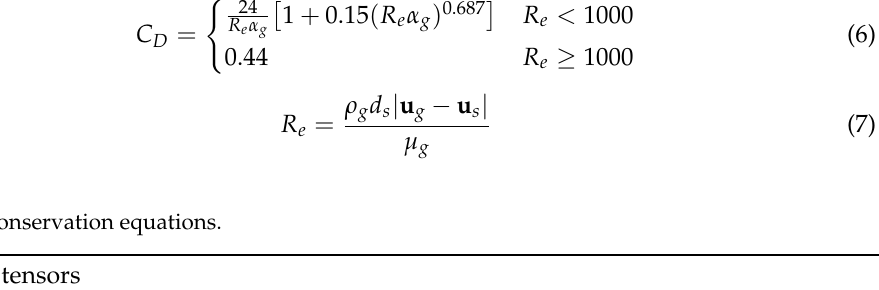
Table 1. Conservation